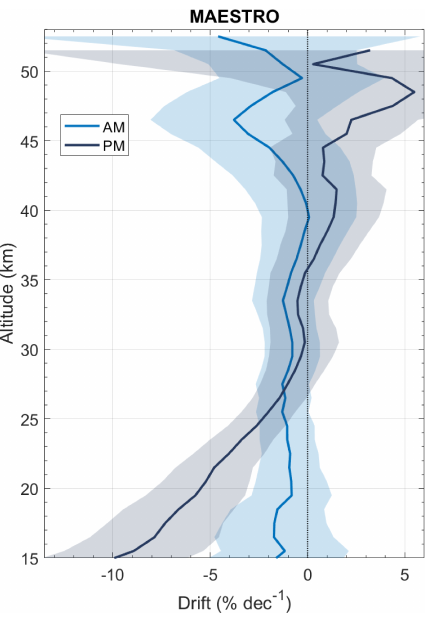
Figure 9. Drift profiles between ACE-FTS v4.1 and MAESTRO for AM (blue) and PM (purple) measurements. Shaded regions (semi- transparent) represent 99% confidence